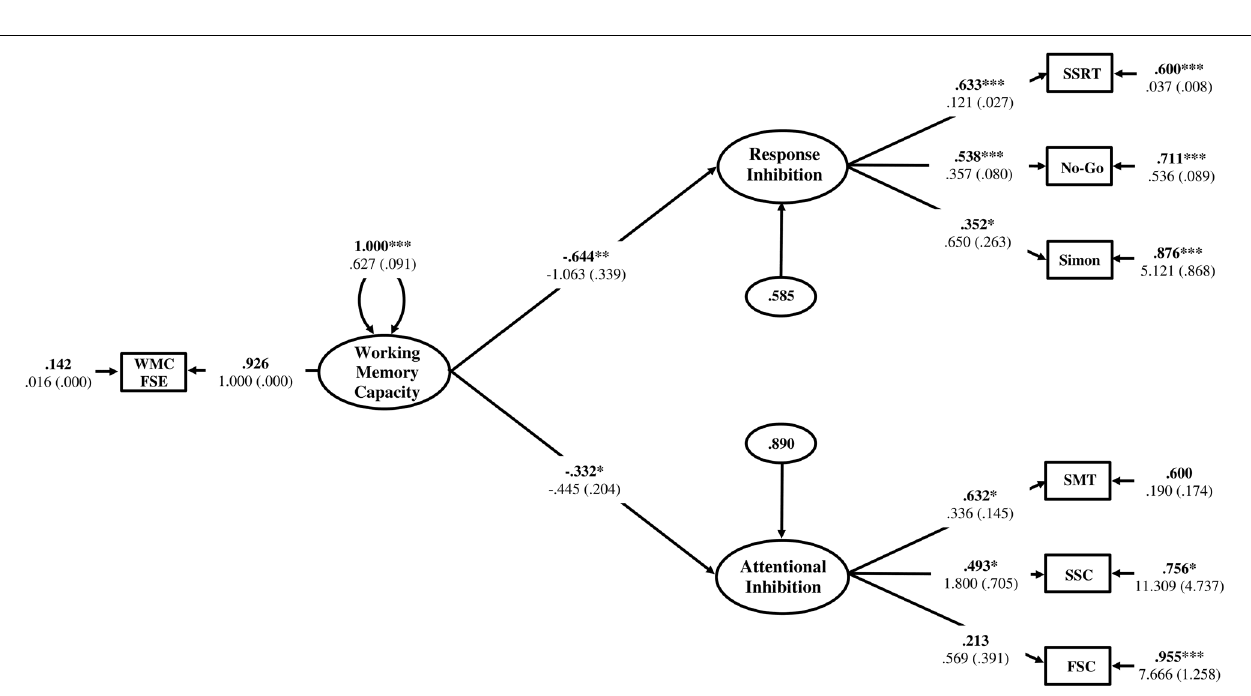
FIGURE 8 | Hierarchical model of inhibitory control with the Response Inhibition and Attentional Inhibition factors regressed onto WMC specified as a higher-order factor. WMC FSE, Working Memory Capacity Factor Scores Estimates; SSRT, Stop-Signal Reaction Time; No-Go, Commission errors on Go/No-Go task; Simon, Simon SR-conflict; SMT, Shape matching SS-conflict; SSC, Stroop SS-conflict; FSC, Flanker SS-conflict. Fully standardized estimates are in bold type face. Numbers below are unstandardized parameter estimates with bootstrapped standard errors in brackets. ∗∗∗ p < 0.001, ∗∗ p < 0.01, ∗ p < 0.05.